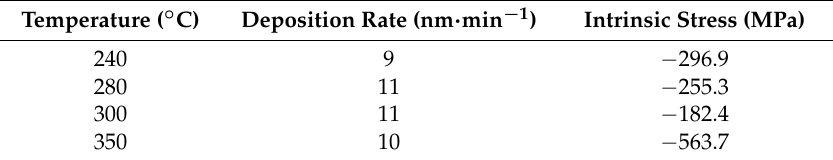
Table 5. Influence of temperature on the intrinsic stress level and deposition